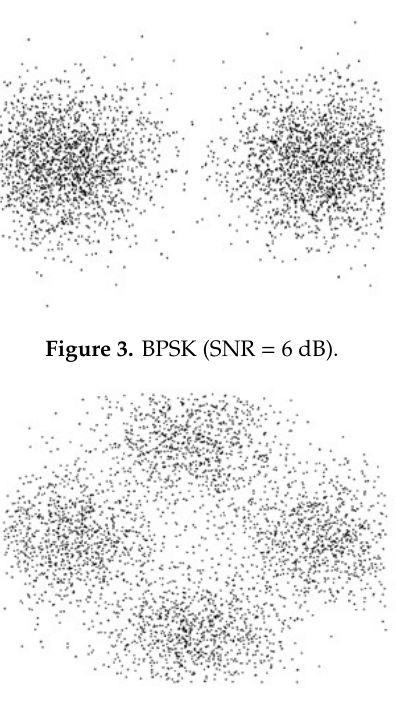
Figure 4. QPSK (SNR = 6 Figure 4. QPSK( SNR = 6 dB)